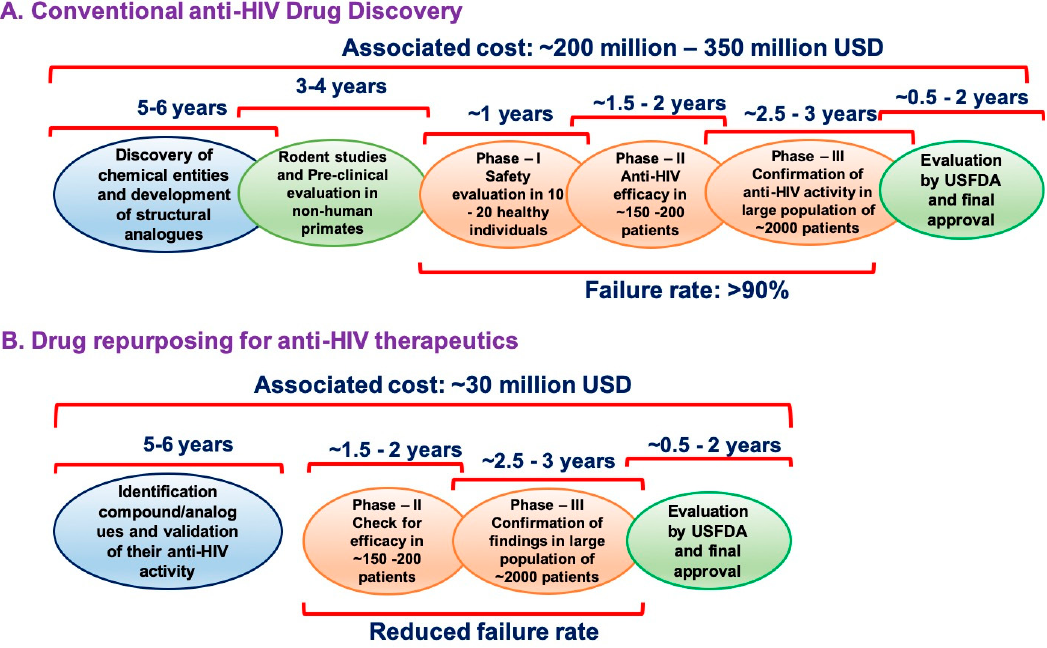
Figure 2. Schematic representation of time and resources associated with conventional development and characterization of novel anti-HIV drugs ( A ) versus drug repurposing approach ( B ). Table 2. Pros and cons associated with activity-based and in silico drug repositioning approaches. Approach